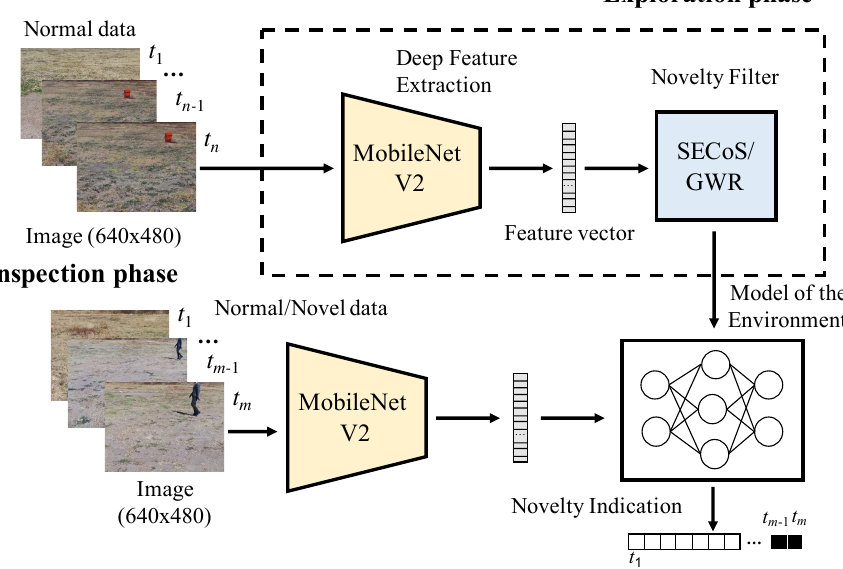
Figure 1. Graphical description of the proposed system for visual exploration and inspection tasks. SECoS: simple evolving connectionist